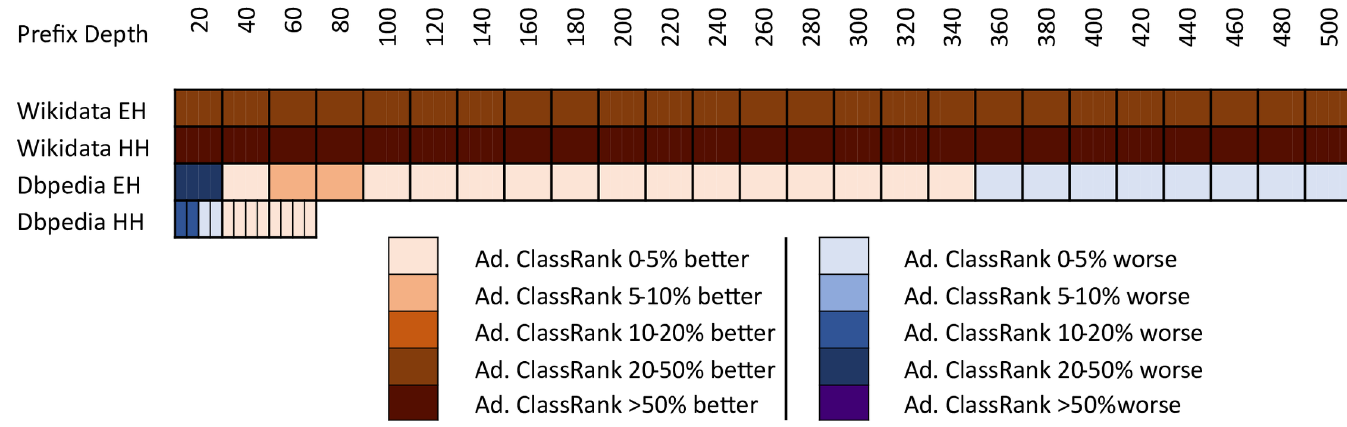
Fig 6. Performance comparison of Adapted ClassRank against any other non-ClassRank metric at every source and prefix depth.